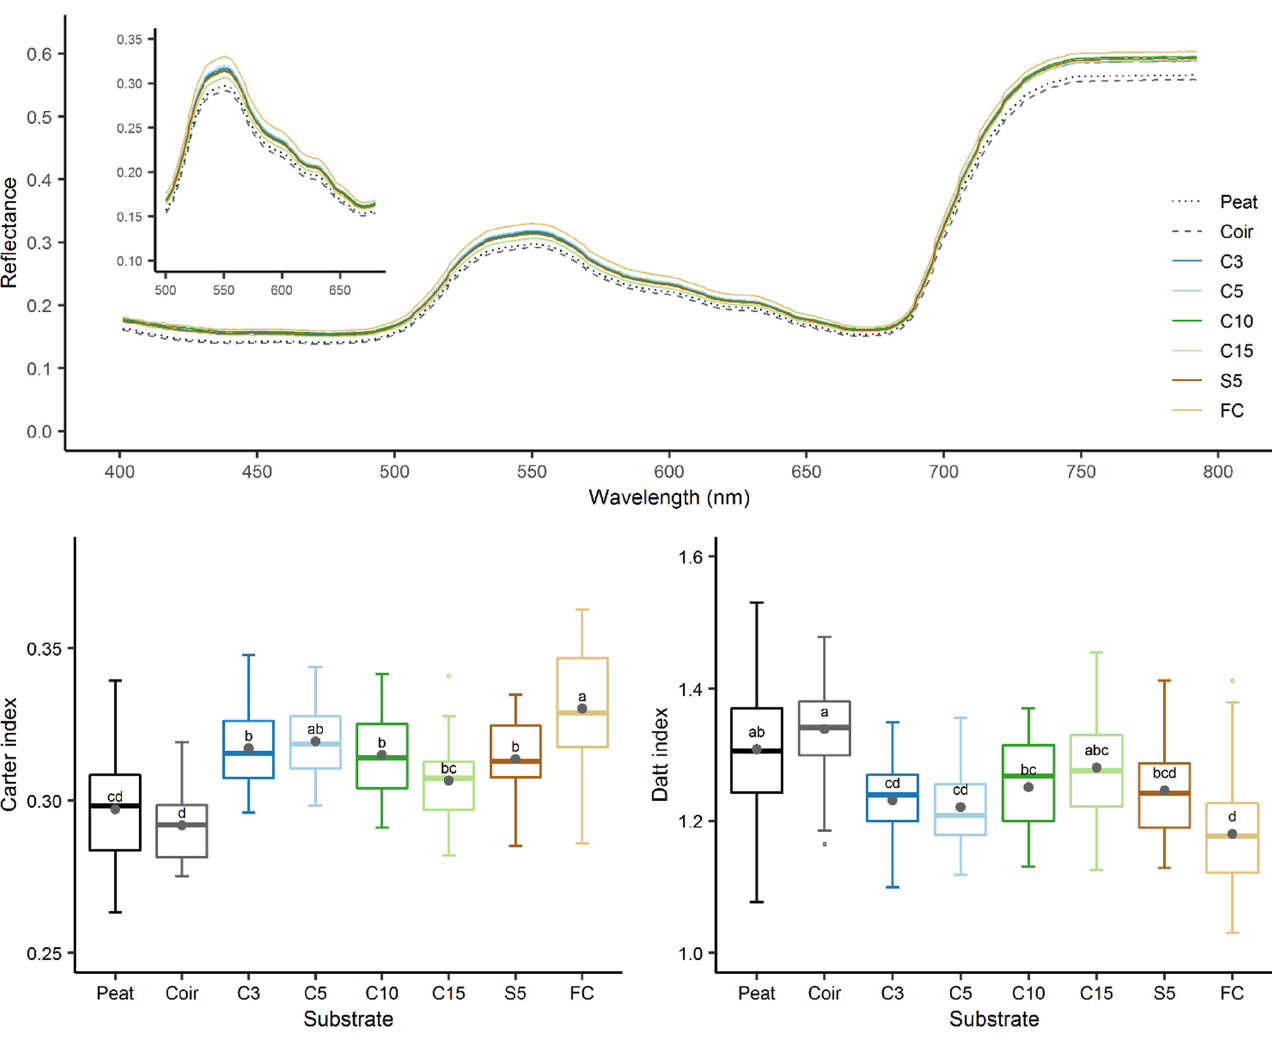
Figure 11. Spectral reflectance measured on the first leaf of Chinese cabbage seedlings at day 23 and computed vegetation index Carter6 and Datt4 based on reflectance at 550, 672, and 708 nm. Different small letters indicate statistically significant differences in means among substrates (Tukey’s HSD, p ≤ 0.05, n = 24). Miscanthus × giganteus was harvested with a forage harvester (FC, field-chips), then processed with a mechanical fraying facility through a 5-mm screen (S5, shreds) or a hammermill with screen sizes of 15, 10, 5, and 3 mm (C15, C10, C5, and C3, chips).